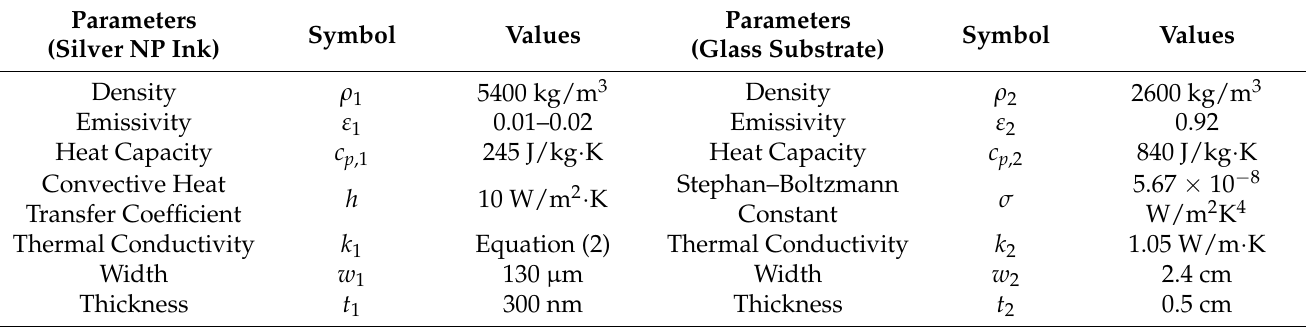
Figure 3. Two-dimensional numerical model of the patterned conductive ink line on the glass substrate. Table 1. Parametric values used in the numerical calculation model.